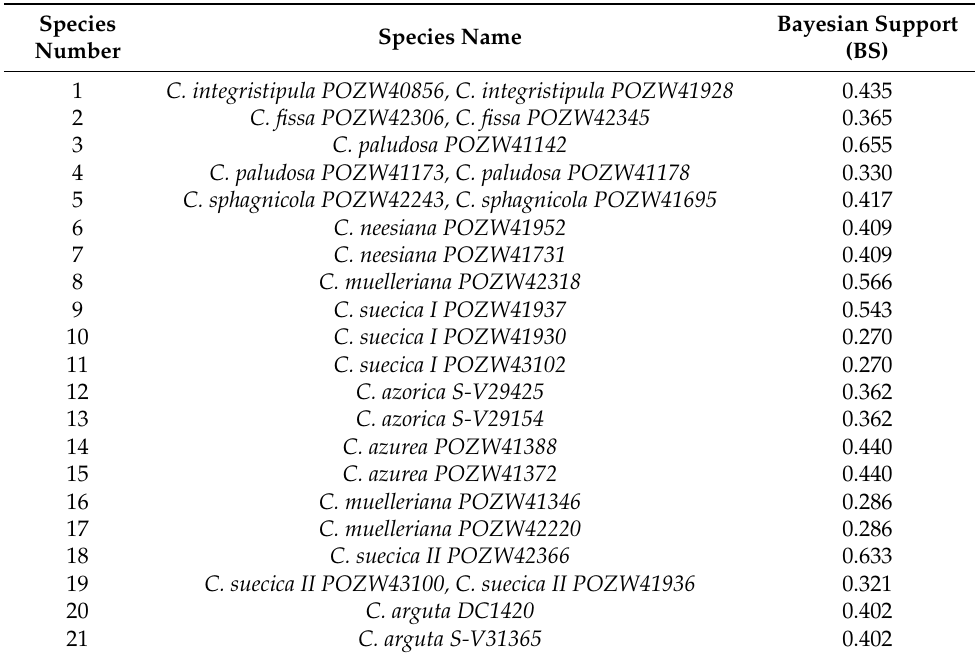
Table 1. Species delimited by bPTP-ML analysis based on chloroplast